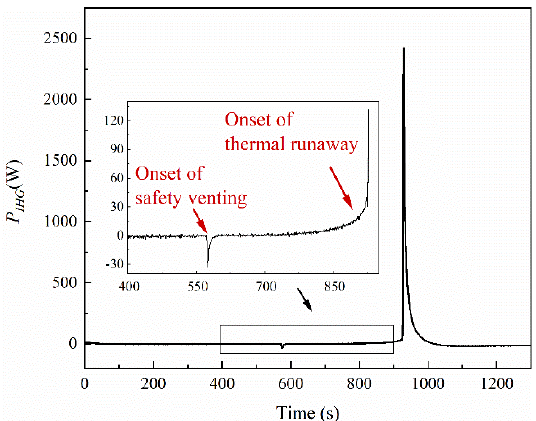
Figure 12. Heat generation by the processes inside LIBs during the thermal runaway process in an open circuit.